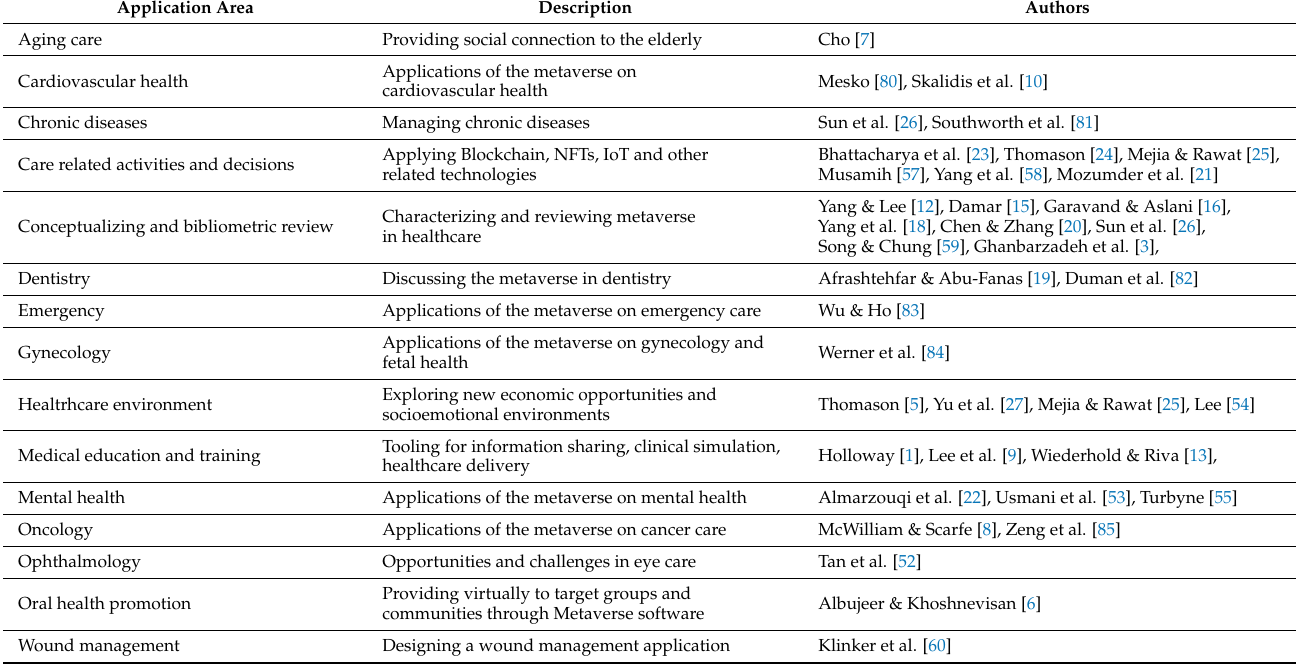
Table 4. Meta-analysis of metaverse service literature review in healthcare